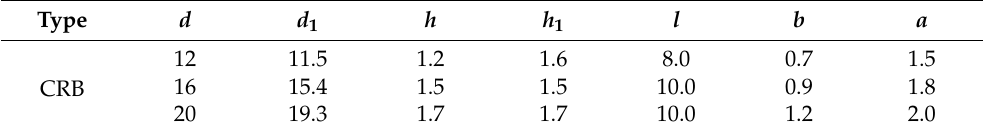
Table 3. The geometrical parameters of CRB (mm).